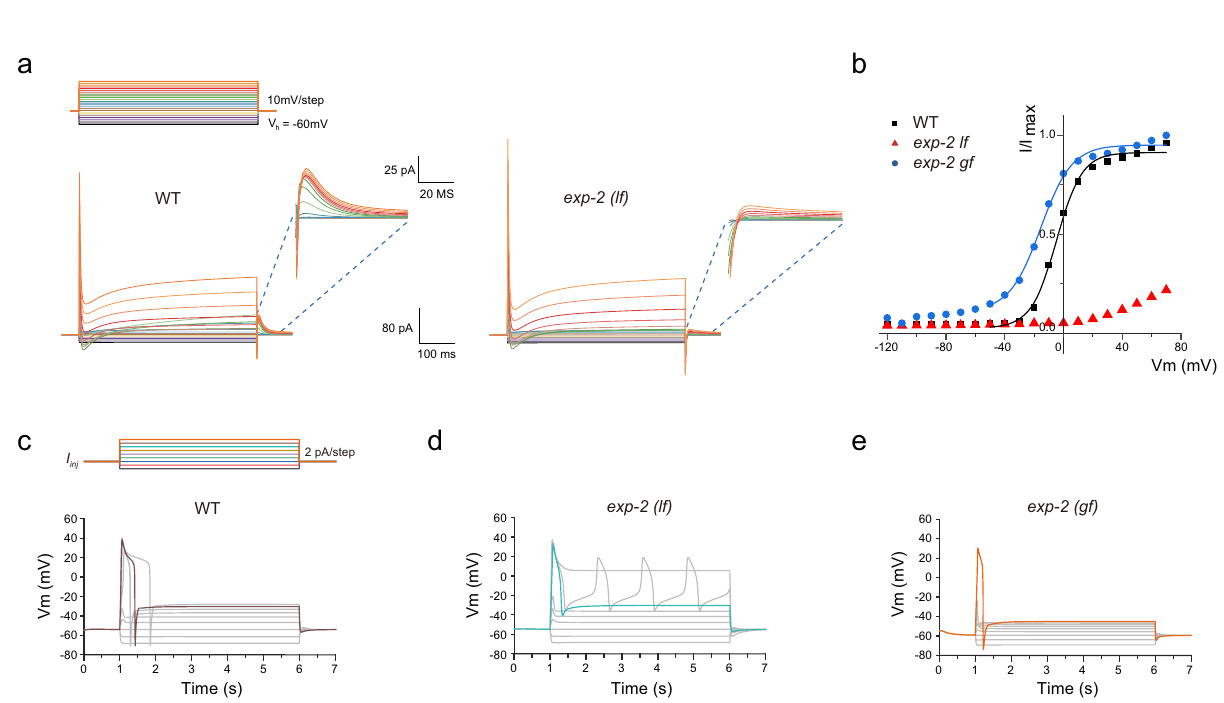
Fig. 3 AVL negative spike is mediated by a repolarization-activated K channel EXP-2. a Representative whole-cell currents recorded from AVL in wild- type (left panel), exp-2 ( lf ) (middle panel), and exp-2 ( gf ) mutant animals (right panel). Top: voltage-clamp steps used: holding potential is − 60 mV, each step is 500 ms long in 10 mV increment. Inserts: zoomed-in view of currents from 0 to ~70 ms after returning to holding potential from serial voltage-clamp steps. b Current-voltage (I – V) relationships of normalized repolarization-activated currents for WT (black square), exp-2 ( lf ) (red triangle), and exp-2 ( gf ) (blue circle). WT and exp-2 ( gf ) IV curves were fi tted with the Boltzmann function (color-matching curves). c Schematic of action potential generation in AVL. The negative potassium spike is intrinsically coupled to the preceding positive calcium spike via a positive-feedback loop mediated by repolarization- activated potassium channel EXP-2. d , e Representative action potential traces recorded from exp-2 ( lf ) and exp-2 ( gf ) AVL. Right panels: overlay of isolated single-action potential spikes from exp-2 ( lf ) (purple traces, note the absence of negative spikes) and exp-2 ( gf ) (orange traces, note the narrow spike width) aligned to the wild-type traces (gray). f Statistical comparison of action potential measurements between different genotypes. The averaged spike width in exp-2 ( gf ) is signi fi cantly narrower than that of the WT. Asterisks indicate signi fi cant differences: ** p = 0.00348. WT measurements are the same as in Figs. 1c and 2g. Resting membrane potential (Vrest): exp -2 ( lf ): − 43.1 ± 1.1 mV; exp-2 ( gf ): − 49.0 ± 2.8 mV. Peak amplitude: exp -2 ( lf ): 9.1 ± 0.4 mV; exp- 2 ( gf ): 9.4 ± 2.4 mV. Threshold: exp -2 ( lf ): − 24.8 ± 0.8 mV; exp-2 ( gf ): − 20.2 ± 1.4 mV. Spike width: exp -2 ( lf ): 334.7 ± 34.5 ms; exp-2 ( gf ): 144.9 ± 12.8 ms. The number of animals recorded per genotype: exp-2 ( lf ): n = 7; exp-2 ( gf ): n = 5. The error bar is SEM. Statistics used was a two-sided two-sample t -test. Source data are provided as a Source Data fi le.